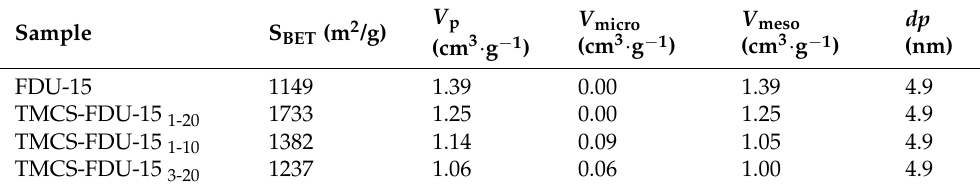
Figure 2. Pore size distribution of FDU-15 and modified FDU-15. Table 2. Pore structure parameters of FDU-15 and modified FDU-15. Table 2. Pore structure parameters of FDU-15 and modified